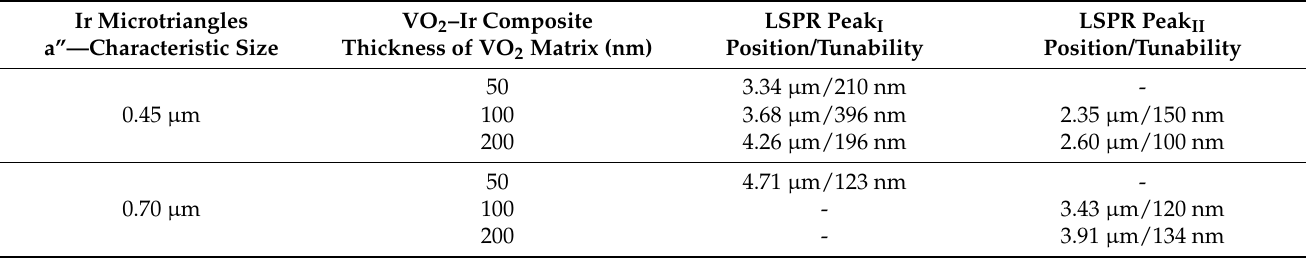
Figure 6. Optical absorbance spectra (calculated as Absorbance = 2-log (Transmittance (%))) of composites vs. of VO 2 thin films; ( a ) Optical absorbance spectra of VO 2 thin films and Al 2 O 3 substrate alone; ( b ) Optical absorbance spectra of composite and of the Ir microtriangles array; ( c ) Temperature evolution of the LSPR position of a 50-nanometer composite made with 0.45 µm Ir microtriangles; ( d ) Temperature evolution of the LSPR amplitude of a 50-nanometer composite made with 0.45 µm Ir triangles. The LSPR position/amplitude are extracted using a Voigt fit function of the temperature dependent absorbance spectra. Table 1. The position and active modulation values of the VO 2 –Ir microtriangles composite’s localized surface plasmon